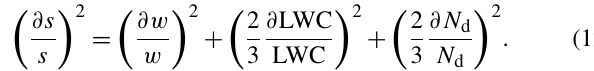
Figure 5. Various retrieved and modified PDFs of input proper- ties and their corresponding PDFs of estimated s : (a) w , (b) LWC, (c) N d , and (d) N d from three different retrieval methods and two constant N d values. Details of the modified variables and retrieval methods are described in the